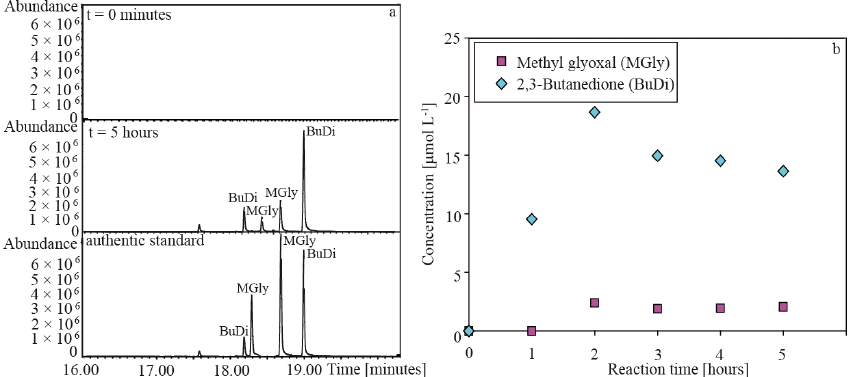
Figure 2. Time-resolved GC/MS chromatograms obtained from the oxidation of 3-methylbutanone (starting time t = 0h and reaction time t = 5h). For comparison the GC/MS chromatogram of the authentic standard compounds of the identified products 2,3-butanedione (BuDi) and methyl glyoxal (MGly) are shown (a) . Using the obtained chromatograms, the concentration of the main products BuDi and MGly was calculated (b)